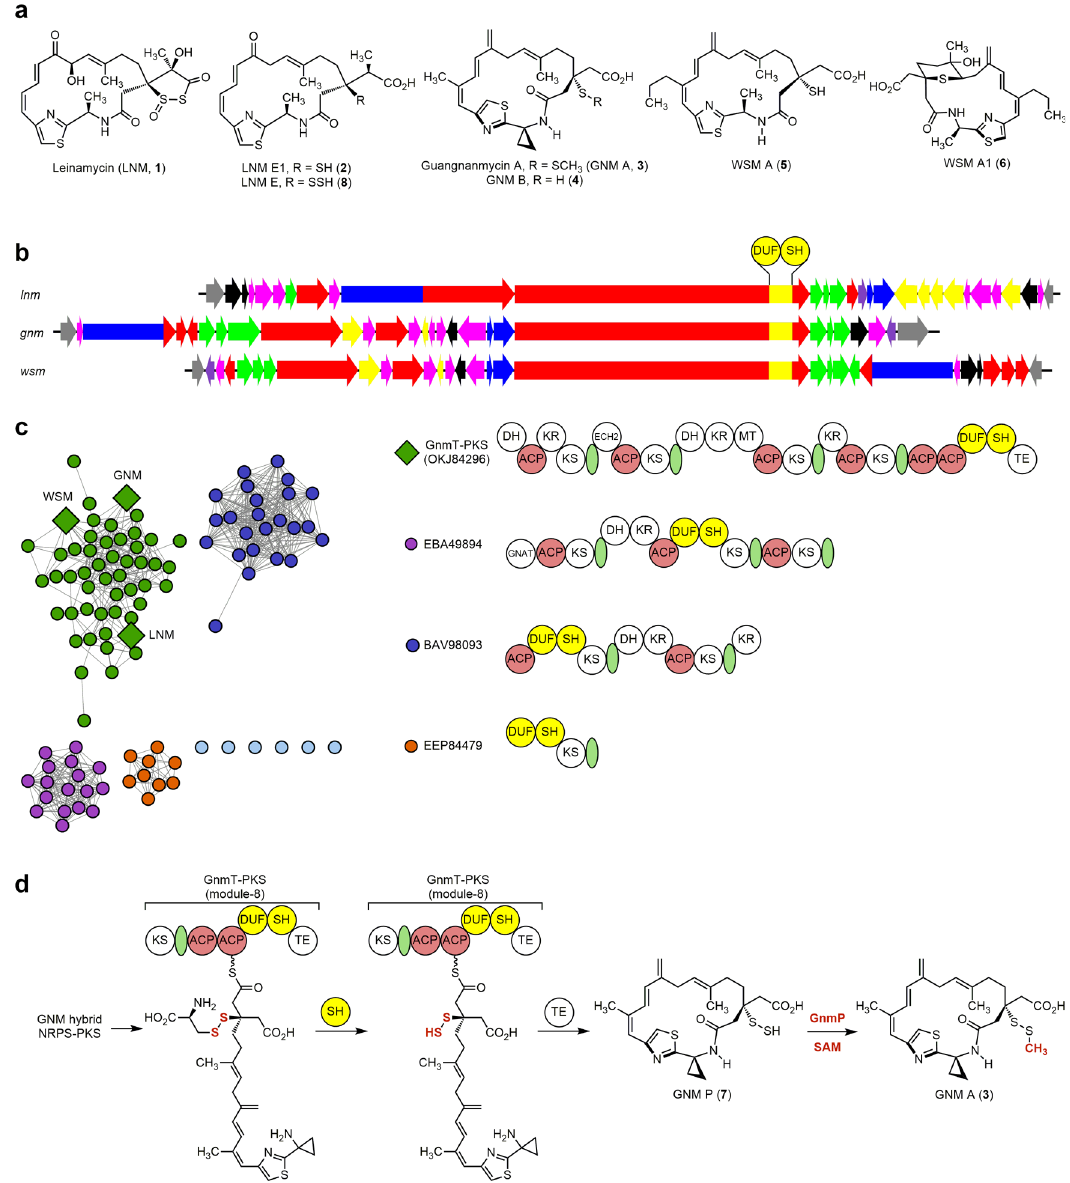
Fig. 1 GNM biosynthesis as a model for the LNM family of natural products featuring a thiocysteine lyase as a PKS domain that directly installs an -SSH group into the GNM hybrid peptide – polyketide scaffold. a The structures of LNM ( 1 ), GNM A ( 3 ), and congeners LNM E1 ( 2 ), LNM E ( 8 ), GNM B ( 4 ), WSM A ( 5 ), and WSM A1 ( 6 ) (Supplementary Fig. 3). b The lnm , gnm , and wsm BGCs featuring DUF-SH didomain-containing type I PKSs. c Sequence similarity network (SSN) of 109 DUF-SH domain-containing PKS proteins revealing four major clusters, with representative PKS modular architectures shown for the four major clusters (see Supplementary Figs. 4 and 5 for a complete summary). The DUF-SH didomain-containing PKS proteins from the LNM-type BGCs are color-coded in green, with the corresponding PKSs from the LNM, GNM, and WSM BGCs depicted as diamonds. d The biosynthetic pathway of 3 highlighting (i) GnmT-SH domain-catalyzed installation of the -SSH group via an L-thiocysteine adduct at C-3 of the growing polyketide chain, (ii) hydropersul fi de 7 as the nascent product of the GNM hybrid NRPS-PKS assembly line, and (iii) GnmP-catalyzed S -methylation of 7 to afford 3 . ACP acyl carrier protein, DH dehydratase, DUF domain of the unknown function, ECH2 enoyl-CoA hydratase homolog 2, GNAT GCN5-related N - acetyltransferase, KR ketoreductase, KS ketosynthase, MT methyltransferase, SH thiocysteine lyase, TE thioesterase, and the green ovals denoting an acyltransferase docking